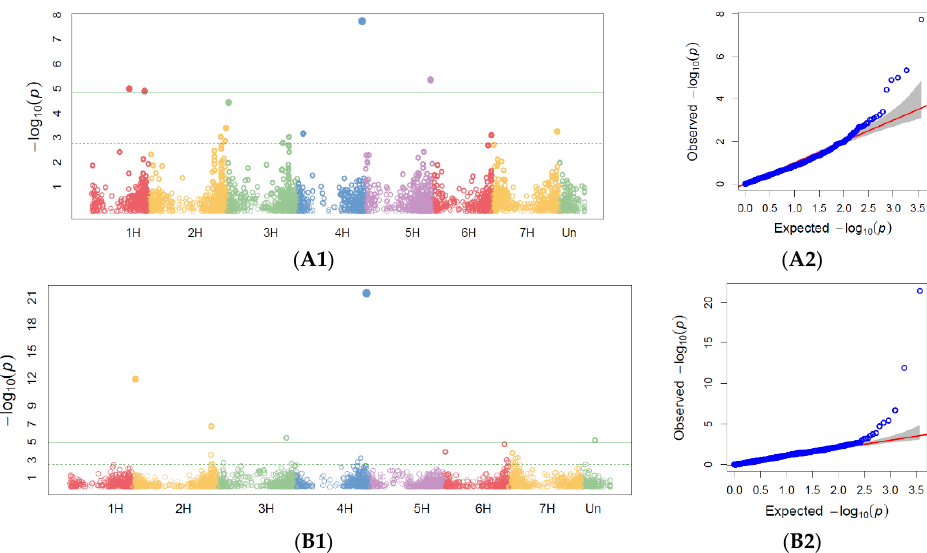
Figure 12. Single-nucleotide polymorphism (SNP) significantly associated with powdery mildew (PM) resistance in barley identified by genome-wide association study (GWAS) with BLINK model. Manhattan plot and quantile–quantile plot for 2019 heading stage Figures ( A1 ) and ( A2 ); Manhattan plot and quantile–quantile plot for maximum disease scores across both growth stages and years Figures ( B1 ) and ( B2 ).